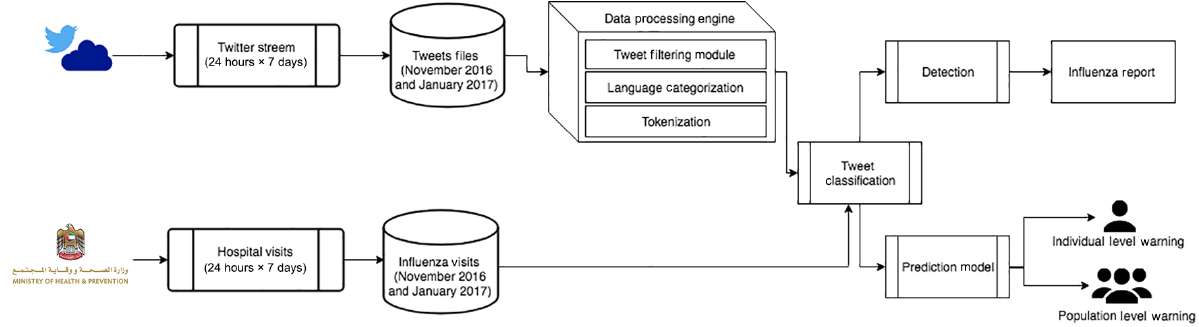
Fig. 1 Tweetluenza system